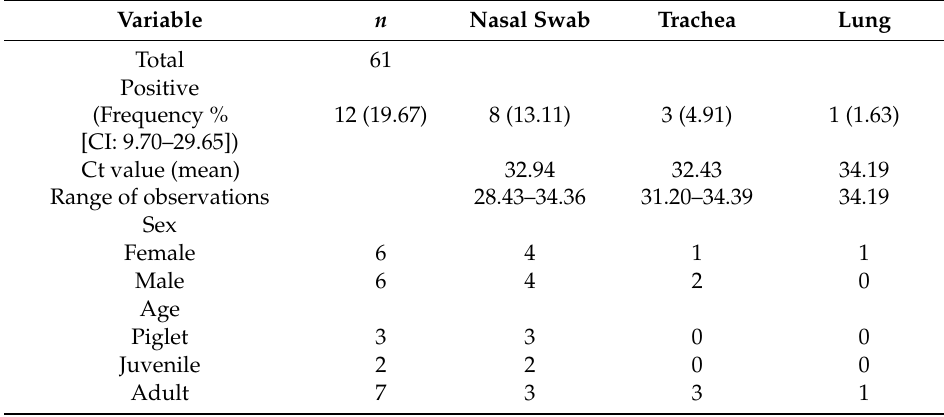
Table 2. Count of wild pig samples positive to qRT-PCR assay. Positivity, frequency, Ct value for qRT-PCR, sex, and age are shown for the total population sampled and for nasal swab, trachea, and lung